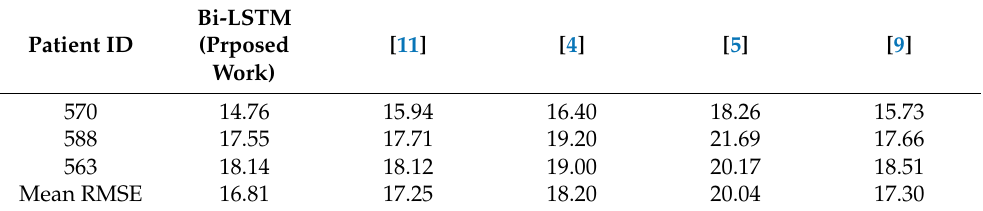
Table 5. Comparison of prediction RMSE with other studies at prediction horizon of 30